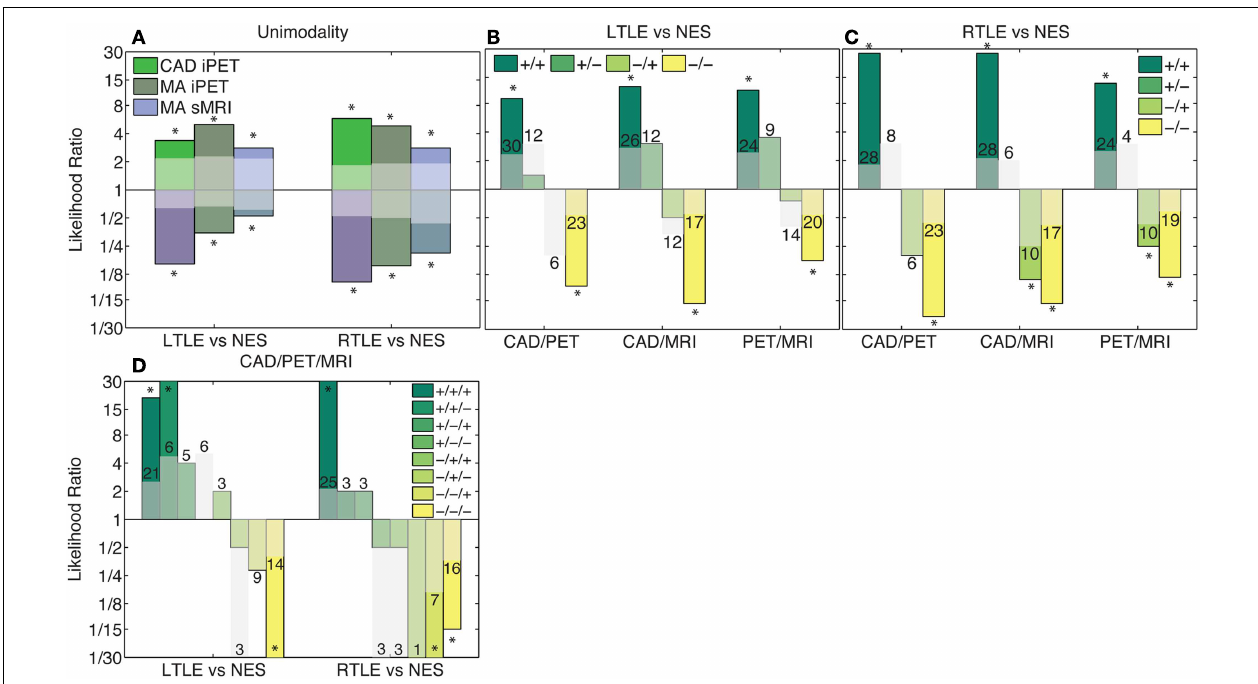
addition of each modality. However, if there is disagreement, the likelihood ratio is generally not significantly different from chance.The translucent bars indicate the 95% confidence interval for chance with the relevant sign (see Materials and Methods).The numbers above the translucent bars indicate the total number of patients with each outcome.The bars that go off the scale of the graph diverge toward zero or infinity because no patients of a certain class had that outcome. *Indicates significant differences of the correlation from zero with a confidence level of 95% or